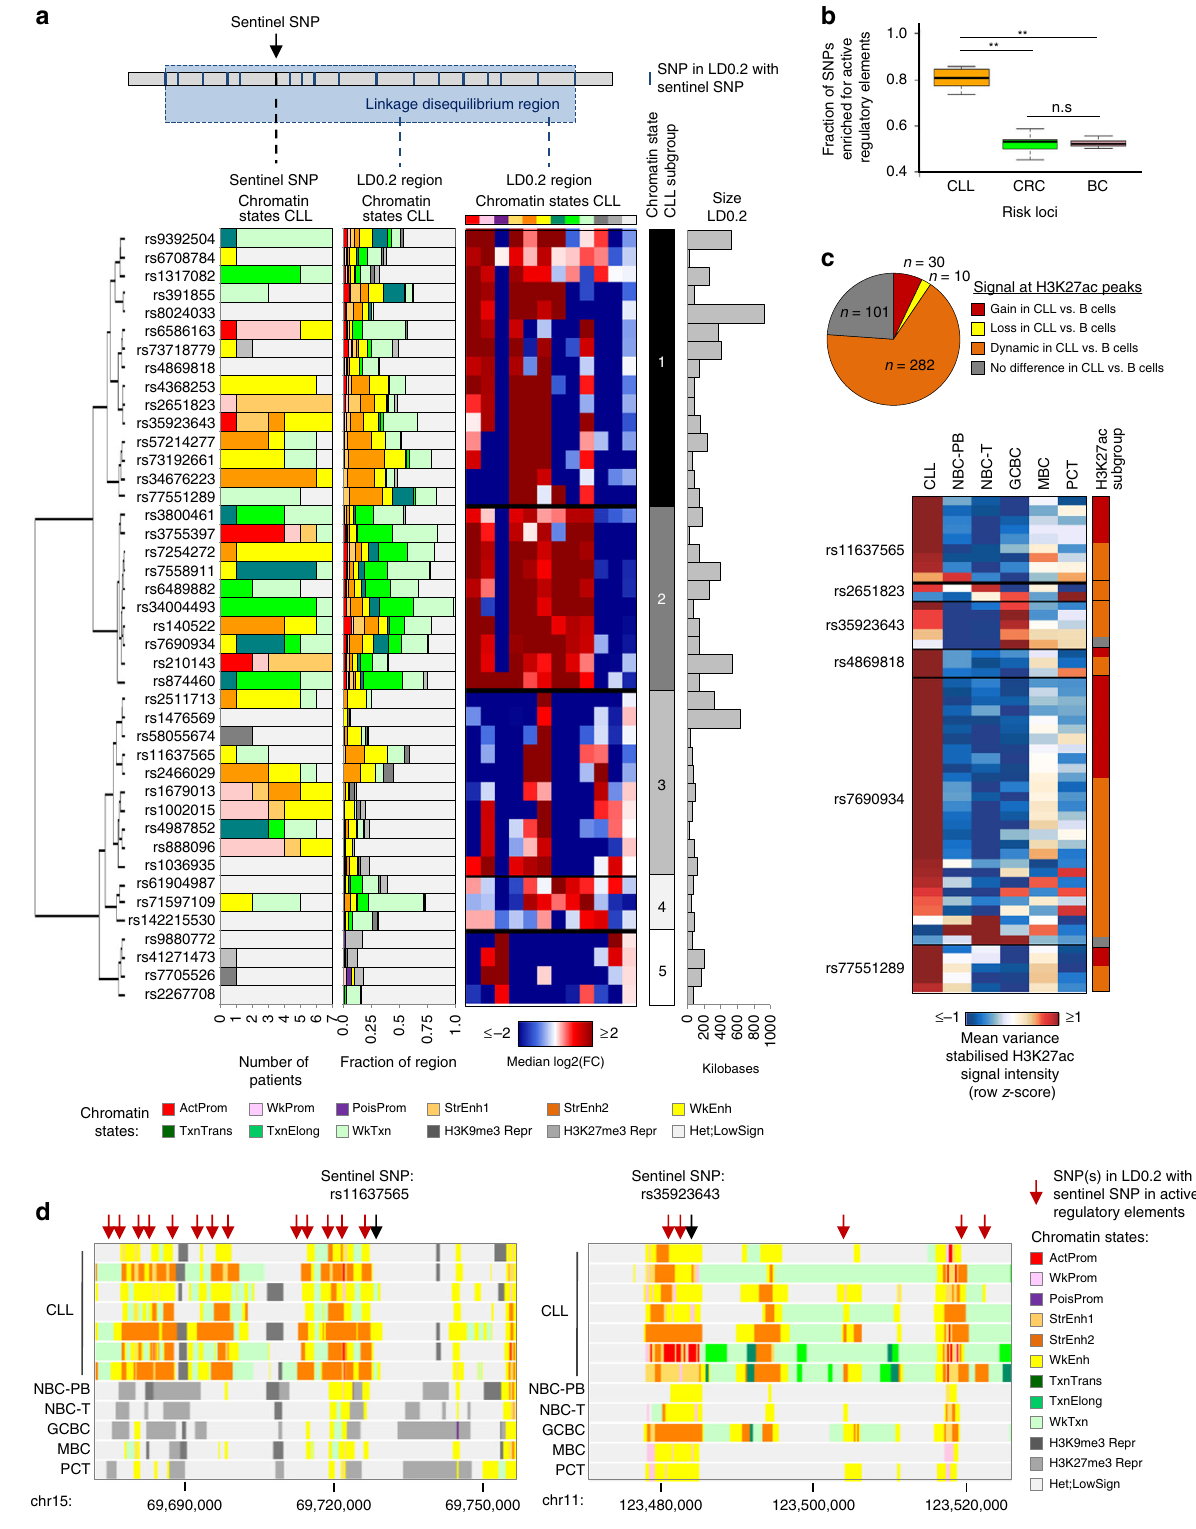
common variants and relatively large effects. Nevertheless, 10% of the risk loci (4/42) showed evidence of allelic imbalance for chromatin accessibility at a total of 9 SNPs (Supplementary Data 9). Eight of these SNPs (89%) overlapped with accessibility QTLs, a signi fi cantly larger fraction than for SNPs that did not show